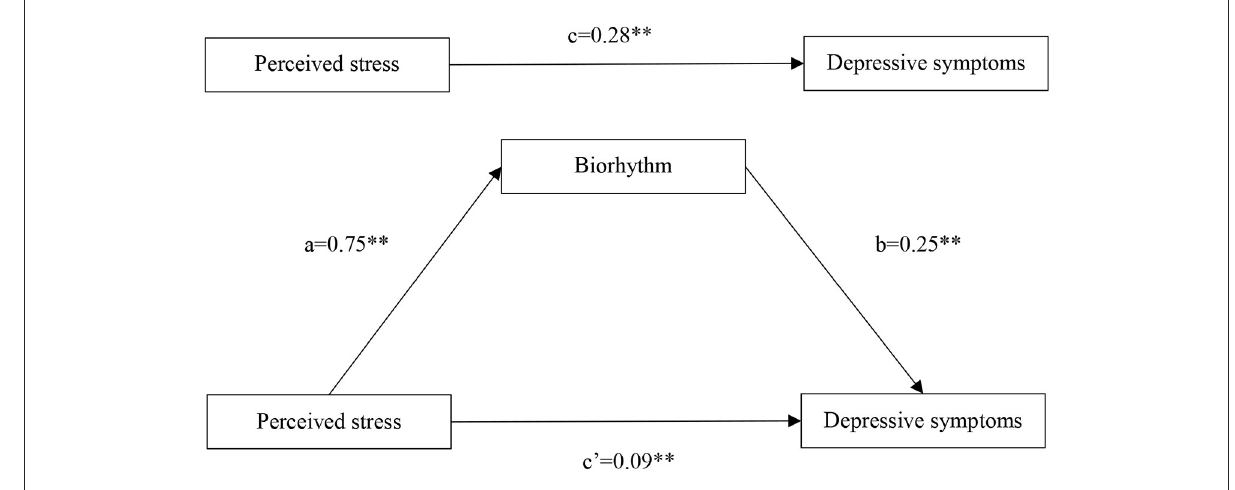
FIGURE2 Propose models that investigate mediated effects ( ** p < 0.001).